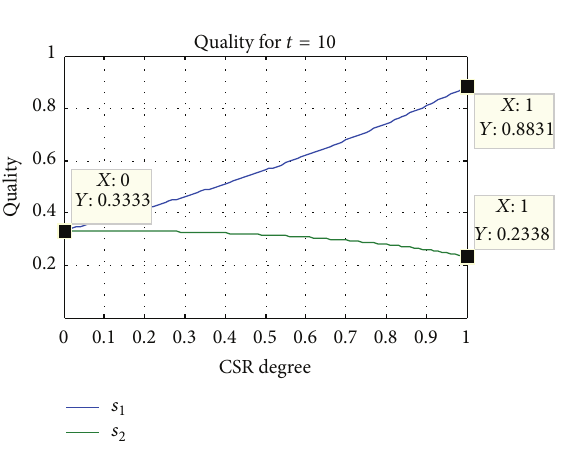
Figure 11: Quality for 𝑡 = 6 .